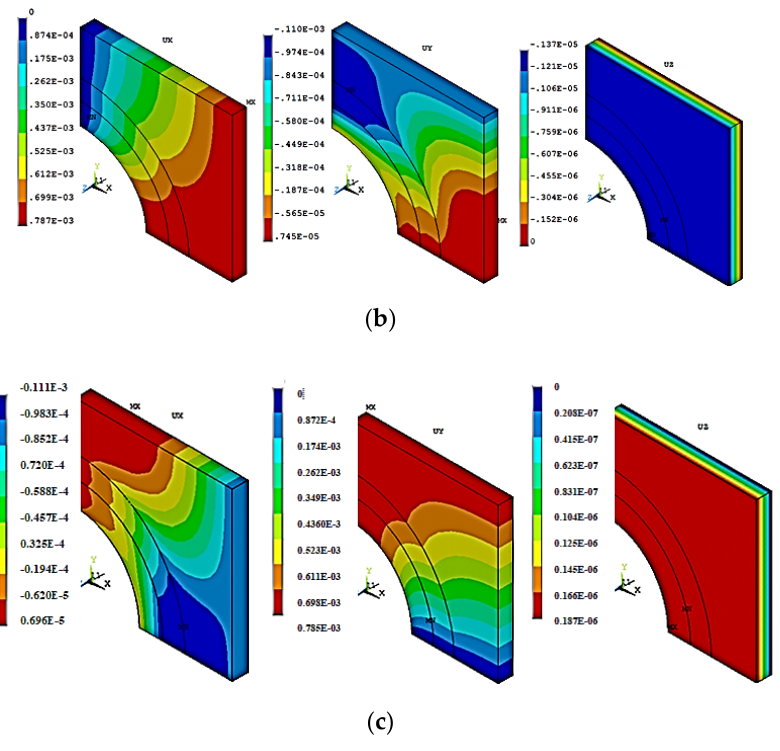
Figure 8. Finite Element contours under longitudinal ( a ), transverse (2-direction) ( b ) and transverse (3-direction) ( c ) loadings of HS-1 model in X, Y and Z directions.